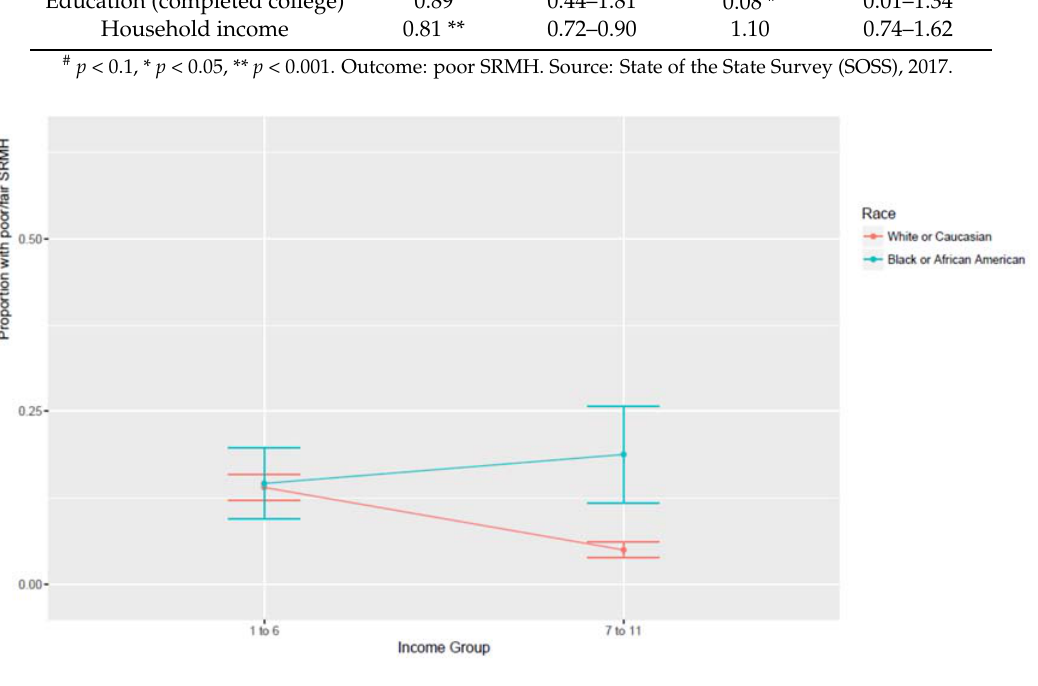
Figure 1. Association between income and SRMH by race.